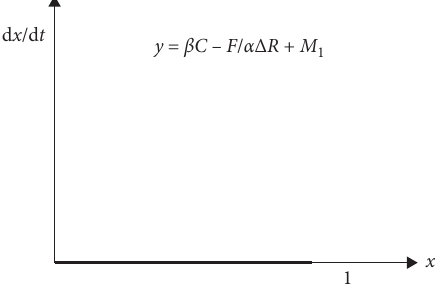
Figure 4: Stable solution for y � (( β C − F ) / ( α Δ R + M